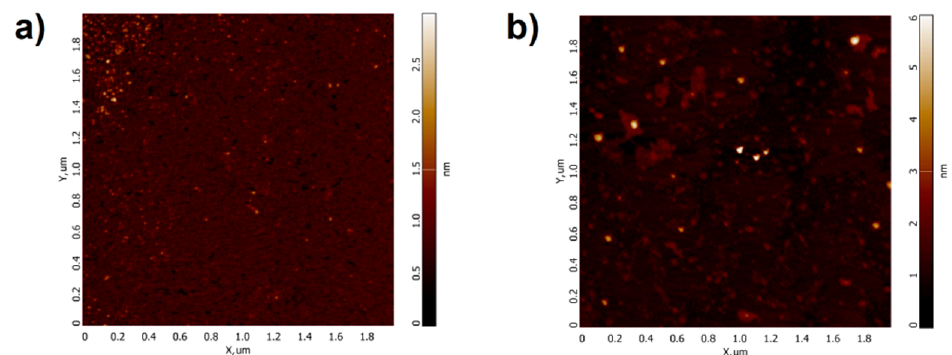
Figure 2. Typical atomic force microscopy (AFM) images of the surface of mica substrate with horseradish peroxidase (HRP) biomolecules adsorbed from the protein solution, which was incubated either far away at a 10 m distance from the polymeric pipe coil (control experiment, ( a )), or near the coil ( b ).